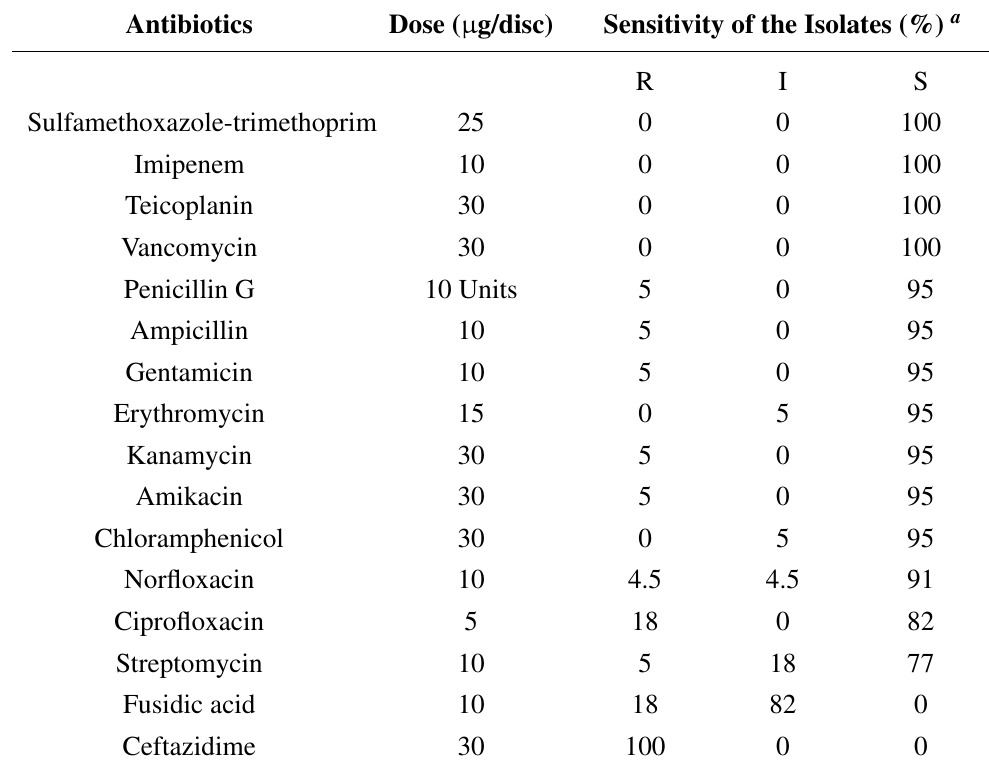
Table 1. Antibiotic susceptibility patterns of Listeria monocytogenes isolates from ready-to-eat food and food processing plant environments.